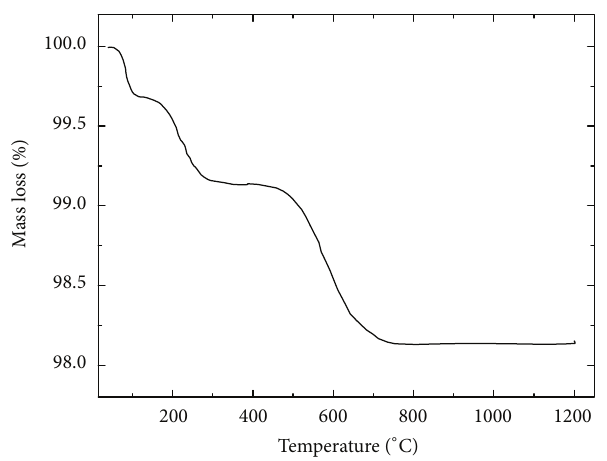
Figure 3: Thermogravimetric analysis of coal fly ash.